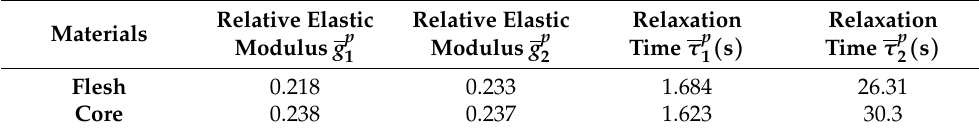
Table 2. The visco-elastic material parameters of carrot for